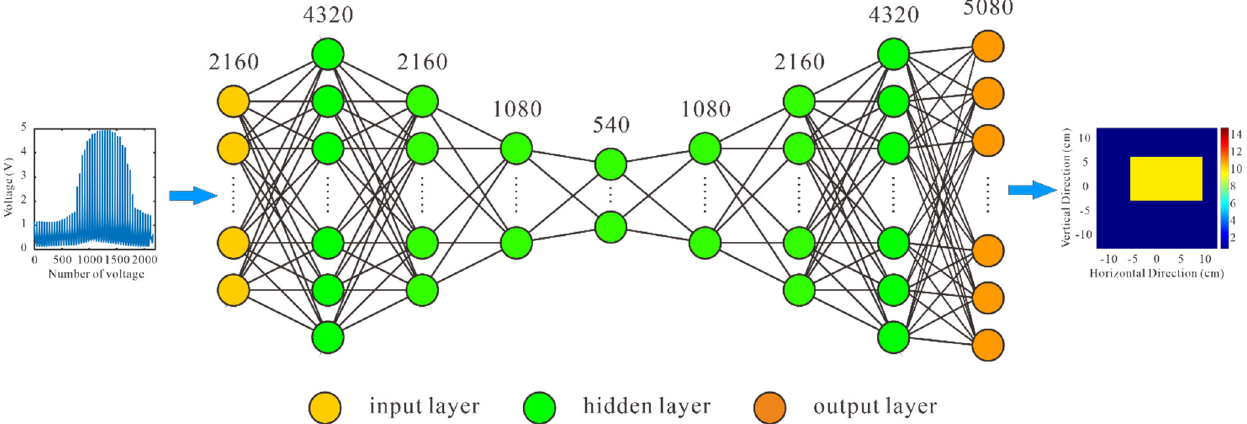
Figure 3. A network structure for ERT inversion.